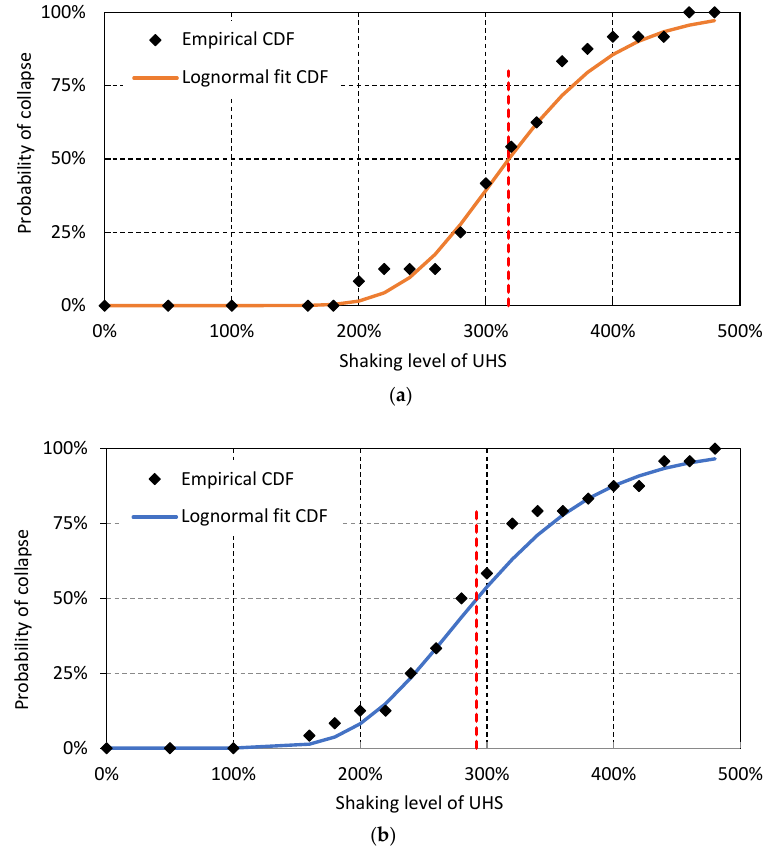
Figure 11. Fragility curves for collapse. ( a ) SD; ( b ) LD motions.